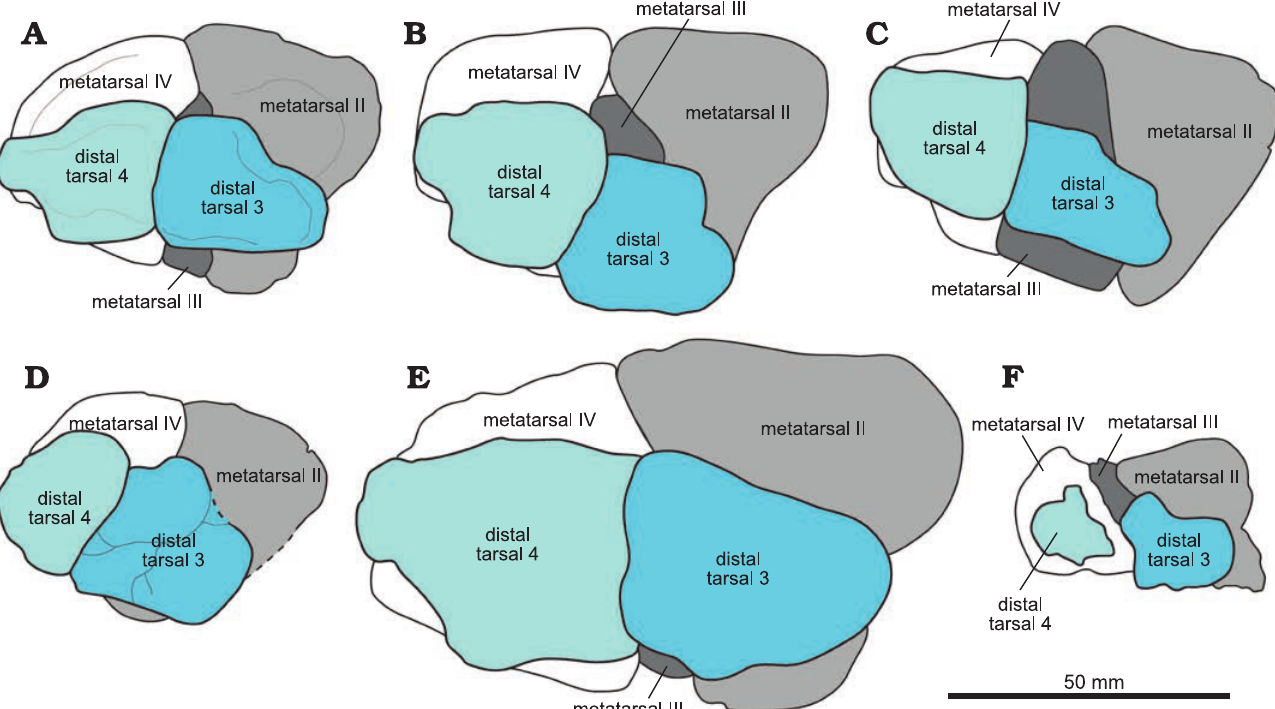
Fig. 3. Comparisons of ornithomimosaur metatarsals with distal tarsals 3 and 4 in proximal view. All are left elements as drawn here, with anterior to the top and lateral to the left of the image, respectively. A . Ornithomimidae indet., RAM 6794. B . Archaeornithomimus asiaticus Russell, 1972, AMNH 6565, redrawn (rotated/reversed) from Smith and Galton (1990). C . Garudimimus brevipes Barsbold, 1981, GIN 100/13, from Kobayashi and Barsbold (2005b). D . Struthiomimus altus Lambe, 1902, CMN 930 from Brad McFeeters personal photos. E . Gallimimus bullatus Osmólska, Roniewicz, and Barsbold, 1972, ZPAL MgD-I/8, redrawn (reversed) from Osmólska et al. (1972). F . Harpymimus okladnikovi Barsbold and Perle, 1984, IGM 100/29, redrawn (rotated) and relabeled from Kobayashi and Barsbold (2005a). Artwork by Hannah Caisse